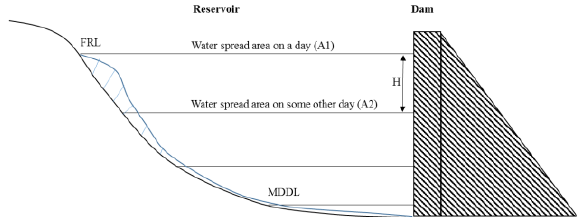
Figure 4. Sedimentation profile in a reservoir